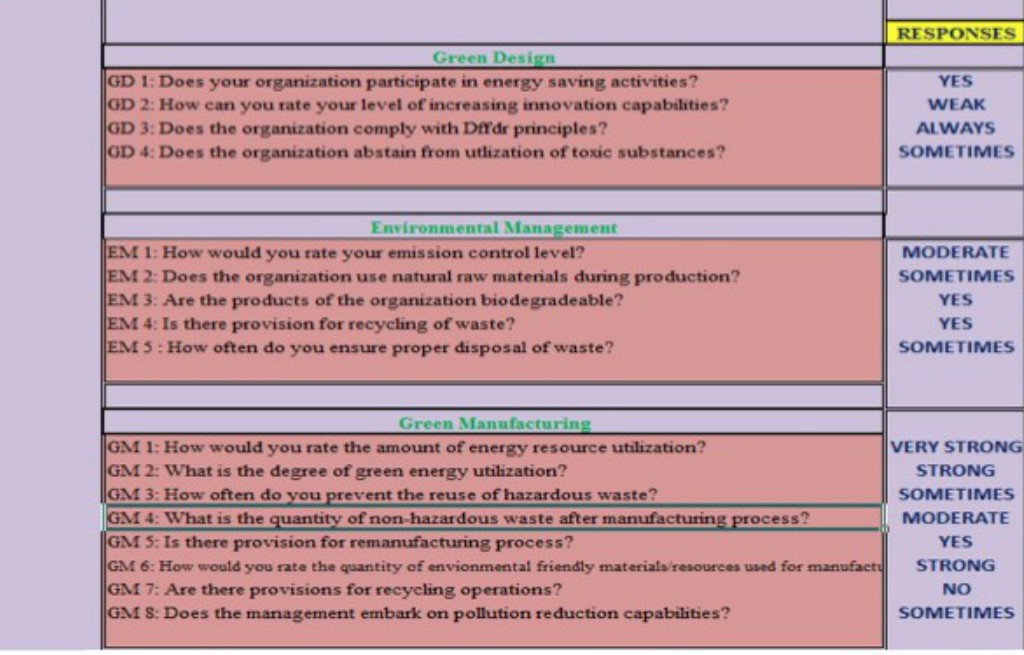
Figure 7. The input section of the performance appraisal application